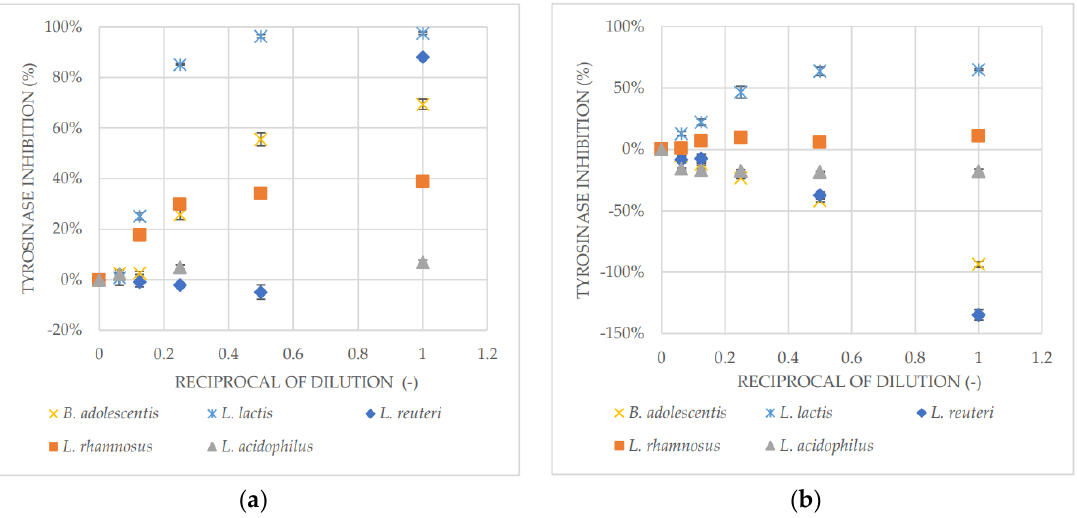
Figure 5. The dilution rates’ reciprocal of tyrosinase inhibition of probiotics ferment filtrates: ( a ) alginite-free ferment filtrates and ( b ) alginite-based ferment filtrates. The highest achieved inhibition of tyrosinase L. reuteri and B. adolescentis alginite-free filtrates had a value of 88% and 69%, respectively. However, the alginite-based ferment filtrates for the same strains reached values of − 94% and − 135% at the same